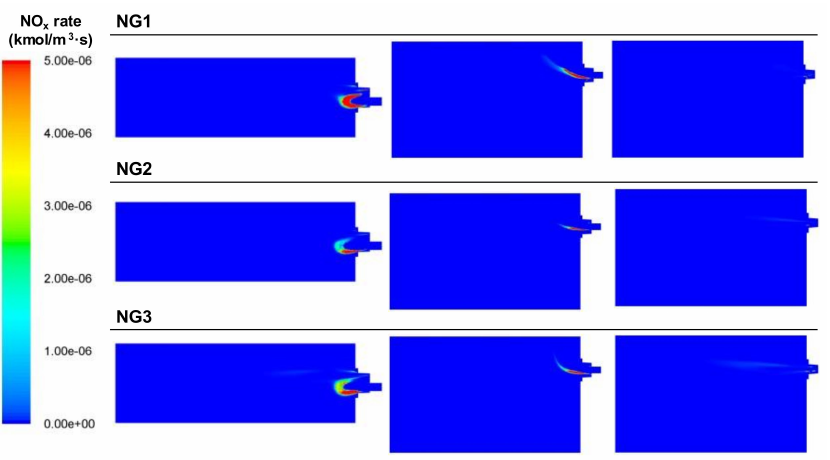
Figure 28. Contour plots of NOx rates for the NG cases in the XZ1, XY1, and XY2 planes.